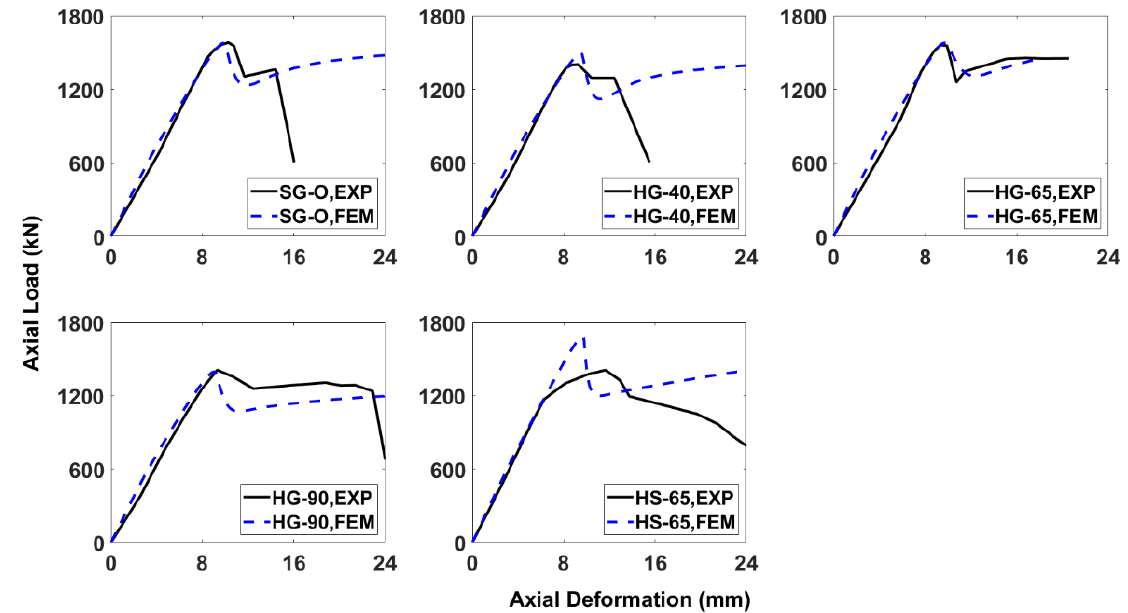
Figure 16. Axial load–axial deformation curves of columns.